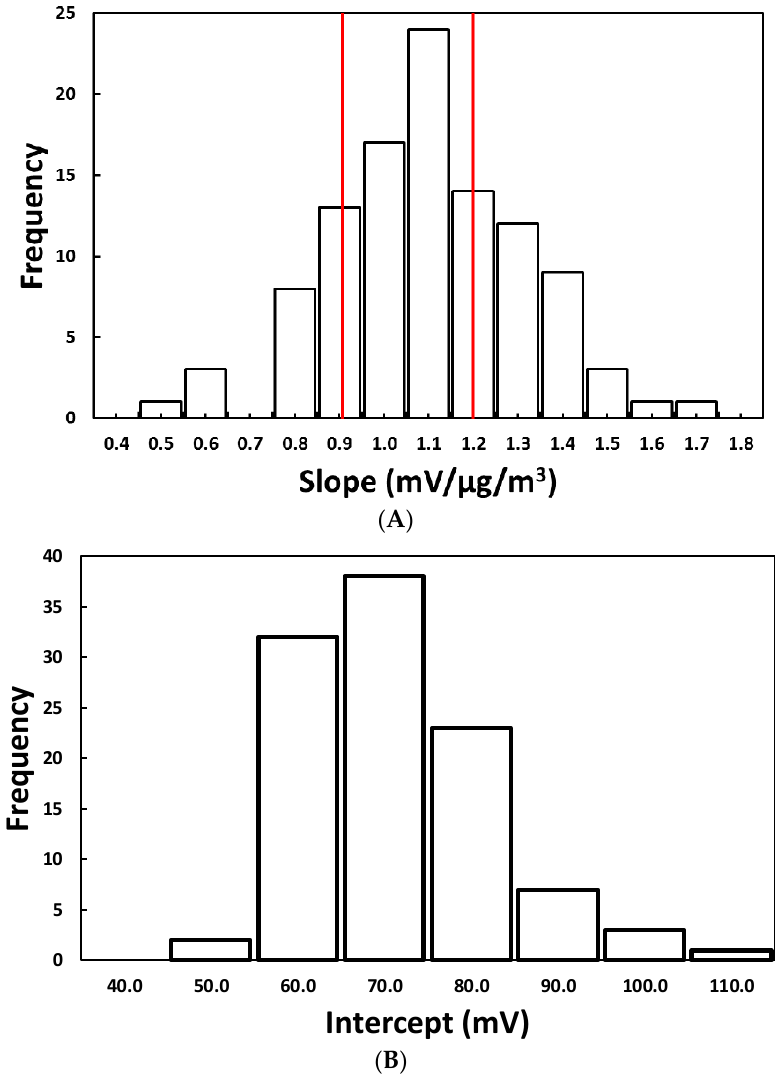
Figure 2. Frequency of ( A ) slopes (solid red lines represent a selection criterion of Z = ±14%) and ( B ) intercepts for the 100 PM sensors determined in laboratory experiments. Table 1. Slopes (mV/µg/m 3 ) for the three sensors used in the three experiments with the mean, standard deviation, and the percent coefficient of variation (CV) for each sensor.